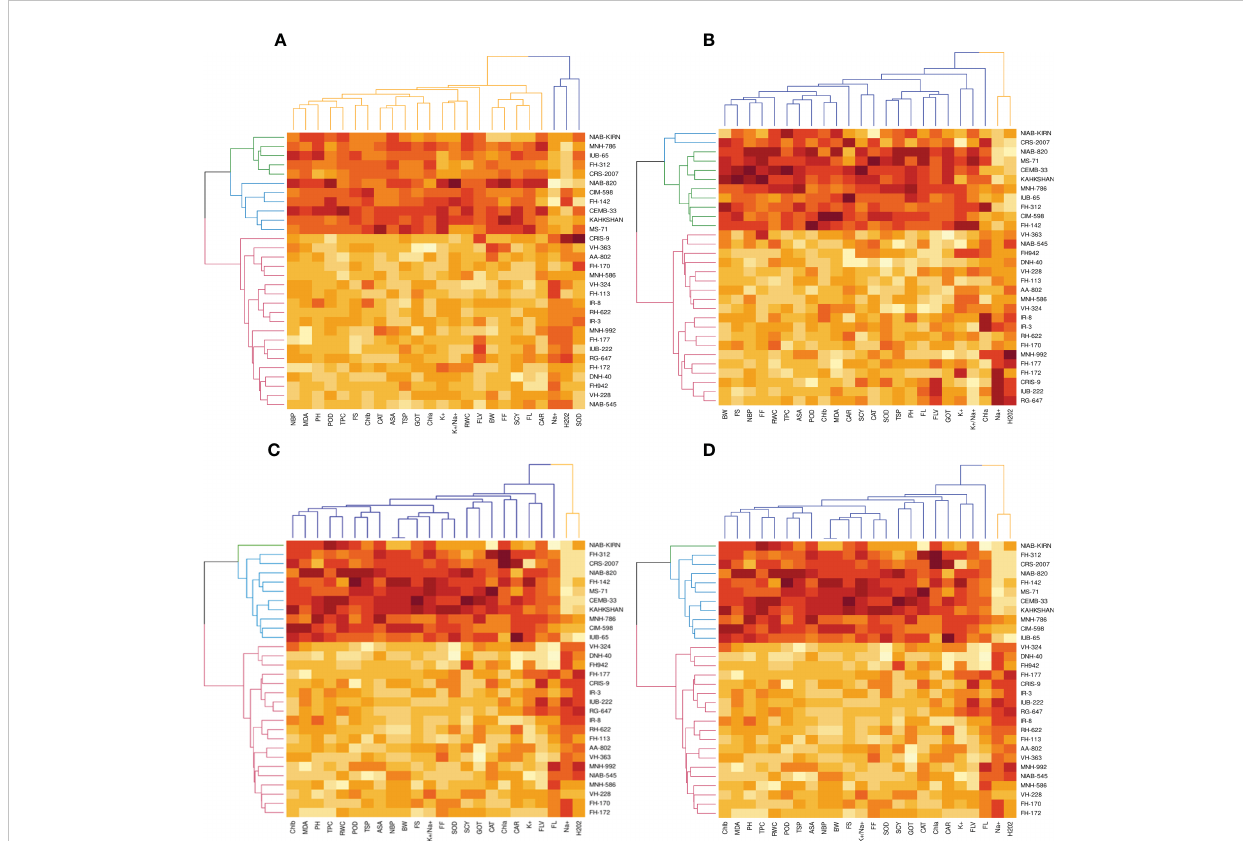
FIGURE 1 First year PCA-Biplot of various agro-physiological, biochemical and fi ber quality traits of 30 cotton genotypes. (A) control, (B) drought stress (D) , (C) heat stress (H), and (D) drought + heat stress (DH). ASA, ascorbic acid; BW, boll weight; CAR, carotenoids; CAT, catalase; Chla, Chlorophyll a; Chlb, Chlorophyll b; FF, fi ber fi neness; FL, fi ber length; FLV, fl avonoids; FS, fi ber strength; GOT, ginning out turn percentage; H202, Hydrogen peroxide; K+, potassium content; K+/Na+, the potassium over sodium ratio; MDA, malondialdehyde; Na+, the sodium contents; NBP, Number of bolls per plant; PH, plant height; POD, peroxidase; RWC, Relative water content; SCY, seed cotton yield; SOD, superoxide dismutase; TPC, total phenolic content; TSP, total soluble